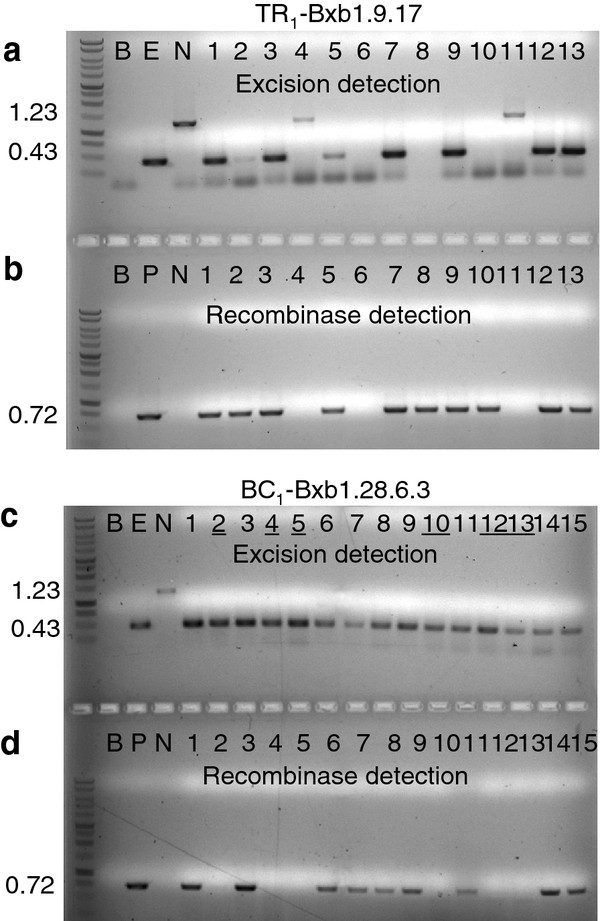
PCR analysis for detection of site-specific recombination and the recombinase transgene in the retransformation (TR1) and back cross (BC1) generations. PCR reactions (a, c) with primers e and f (Figure 1) or (b, d) with primers g and h (Figure 1) on representative plant DNAs. a, b) retransformed TR1-Bxb1.9.17 lines. c, d) Back crossed line BC1-Bxb1.28.6.3. Control lanes are B (blank, no DNA); E (excision, pN6-Bxb1exc DNA); N (no excision, pN6-Bxb1); P (pCOXS3-Bxb1). c) Lane numbers underlined indicate presence of excision event in the absence for the Bxb1 gene.